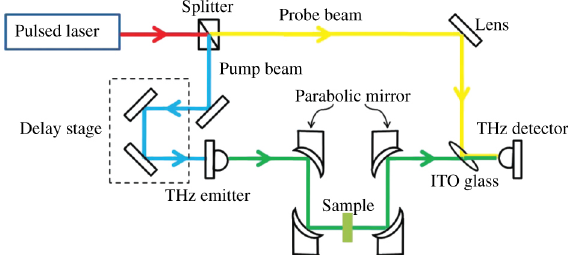
Figure 2: Schematic of the THz-TDS